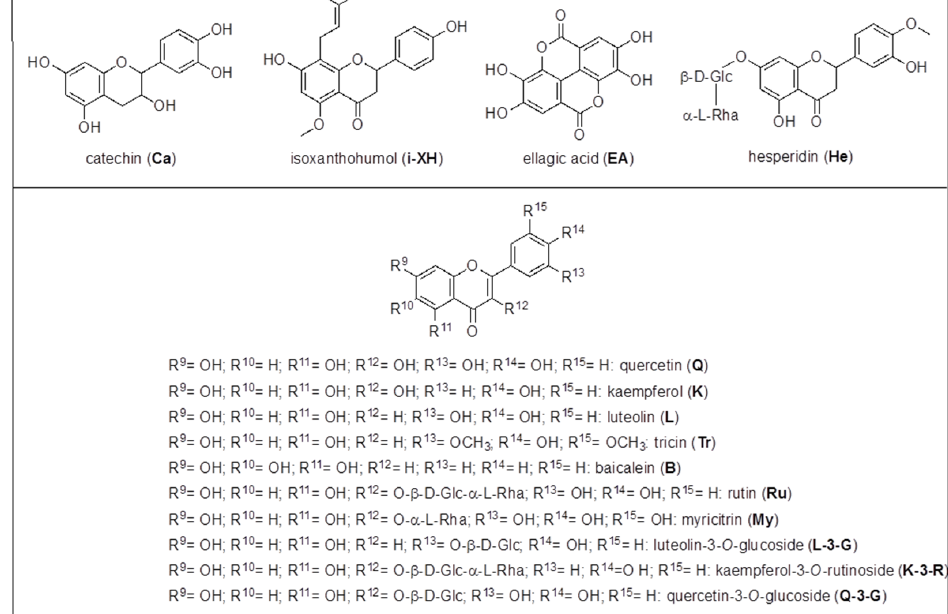
Scheme 5. Flavonoids (Fs) structures.